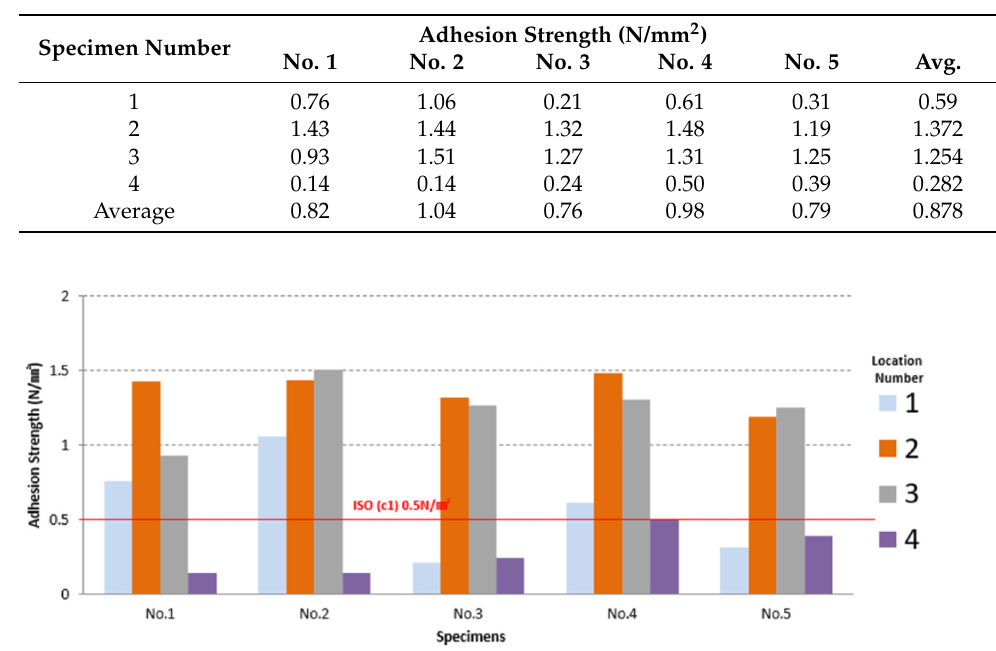
Table 5. Adhesion strength result of the specimens based on ISO standard evaluation.